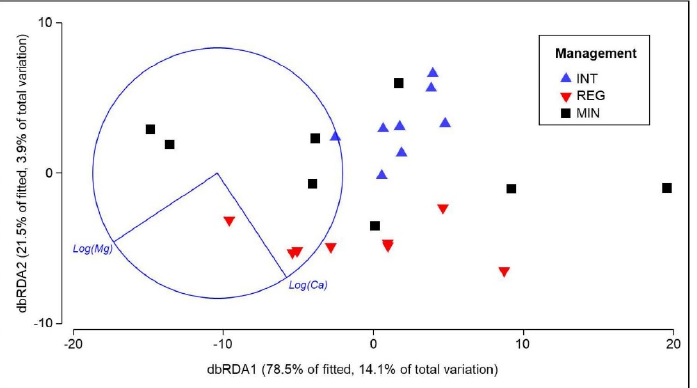
Figure 4. Distance-based redundancy analysis (dbRDA) plot of the DistLM using the two explanatory variables included in the best model. Vectors indicate the direction of the parameter effect in the ordination plot.